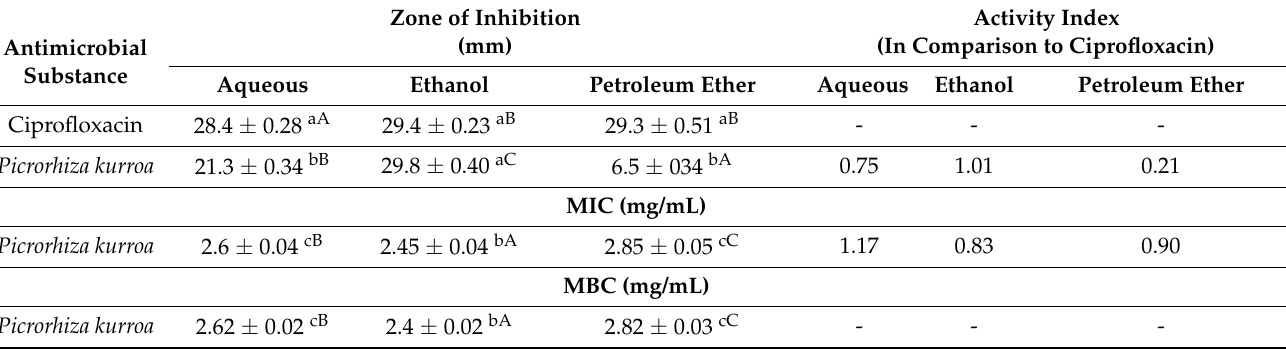
Table 1. Antimicrobial activity of the herbal extract against Yersinia enterocolitica , using the agar–well